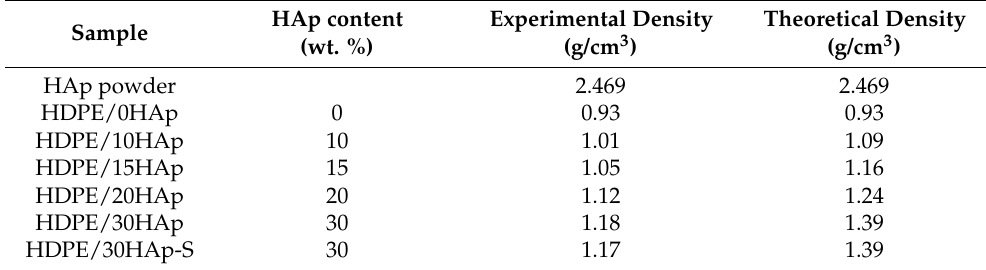
Table 3. Density of the HDPE/HAp